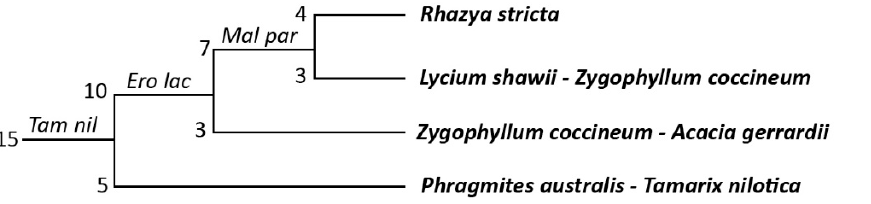
Figure 3. TWINSPAN dendrogram of different sampled stands based on the importance values of the recorded perennial species ( n = 49). Indicator species names are abbreviated to the first three letters of both genus and species. Mal par : Malva parviflora , Ero lac : Erodium laciniatum , and Tam nil : Tamarix nilotica . Table 1. Plant communities of the perennial species recorded in the study area.